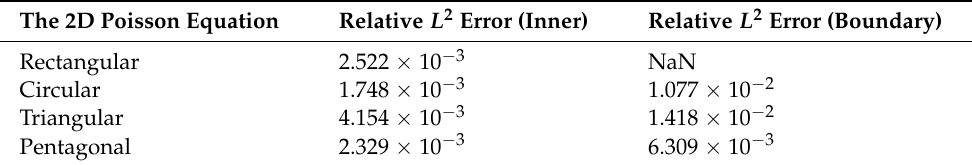
Figure 9. cSPINNs results (with ResNet block-enhanced modified neural network) for solving the L-shaped Poisson equation with the reference solution. Table 2. The 2D Poisson equation: Relative L 2 errors obtained by cSPINN on different geometries. ( Ω 2 = [ 0,1 ] × [ 0,1 ]